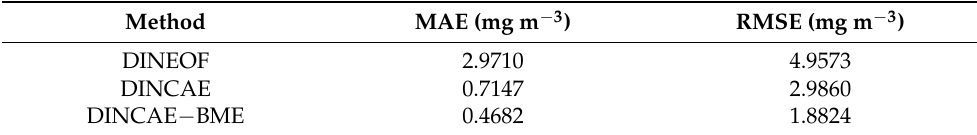
Table 4. Results of hold–out cross–validation with different methods.